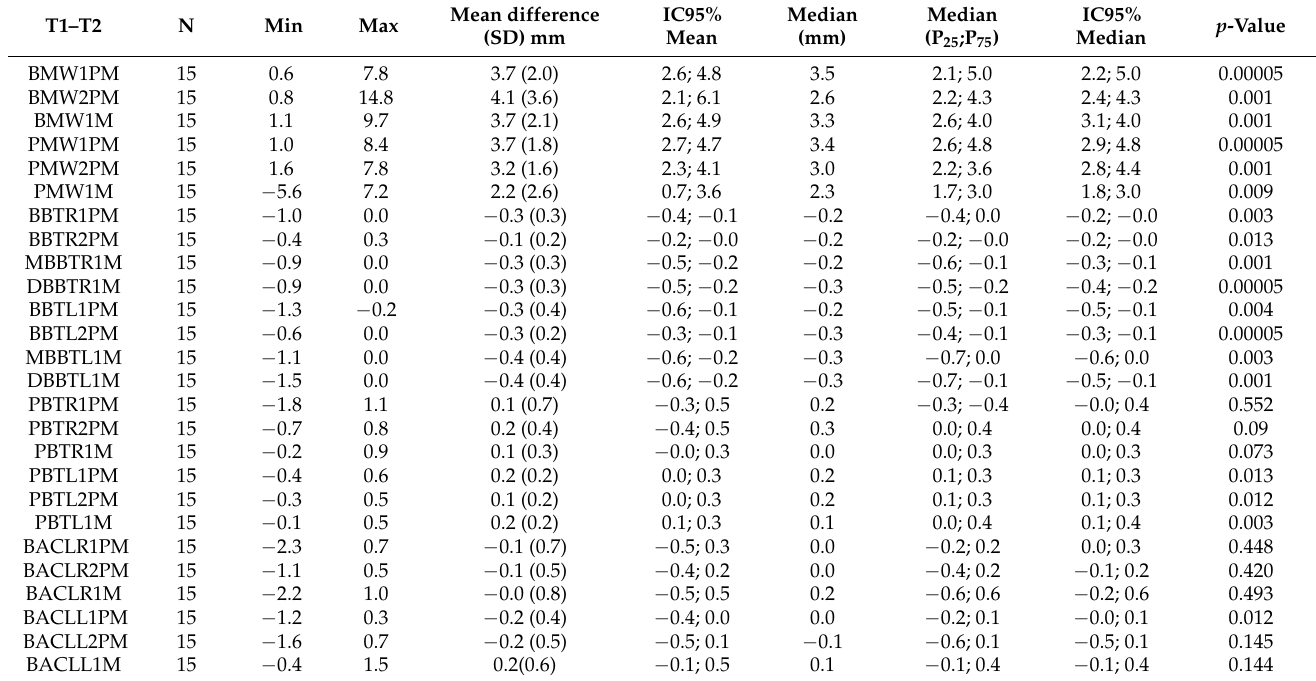
Table 7. Comparison of Pre and Post treatment Dentoalveolar measurements. Dentoalveolar